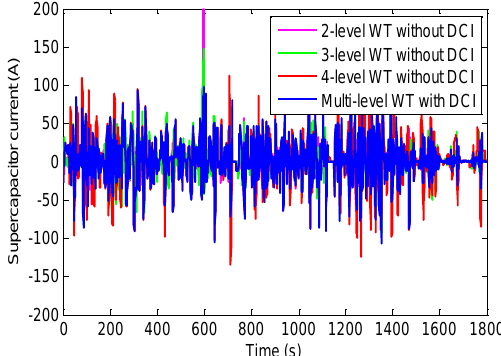
Figure 27. Current comparison of supercapacitor bank. WT, wavelet transform; DCI, driving cycle identification.